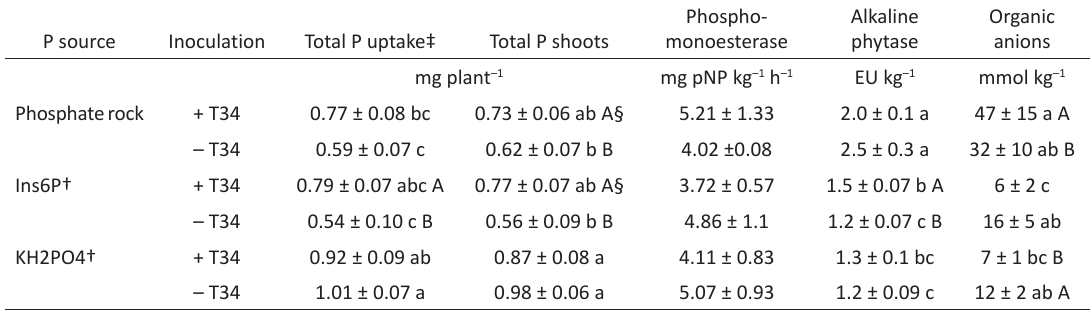
Table 5. Effect of the significant interactions between main factors on properties of the plant growth media and concentration and total content of P in